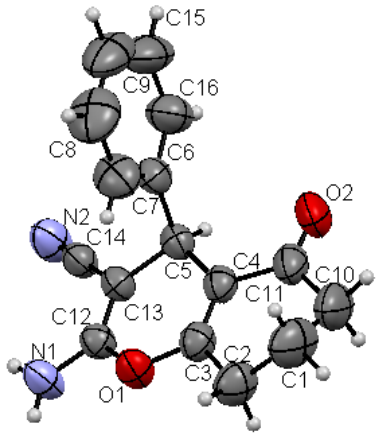
Figure 5. X-ray crystal structure of ( R )-2-amino-5-oxo-4-phenyl-5,6,7,8-tetrahydro-4 H - chromene-3-carbonitrile ( 6h ).